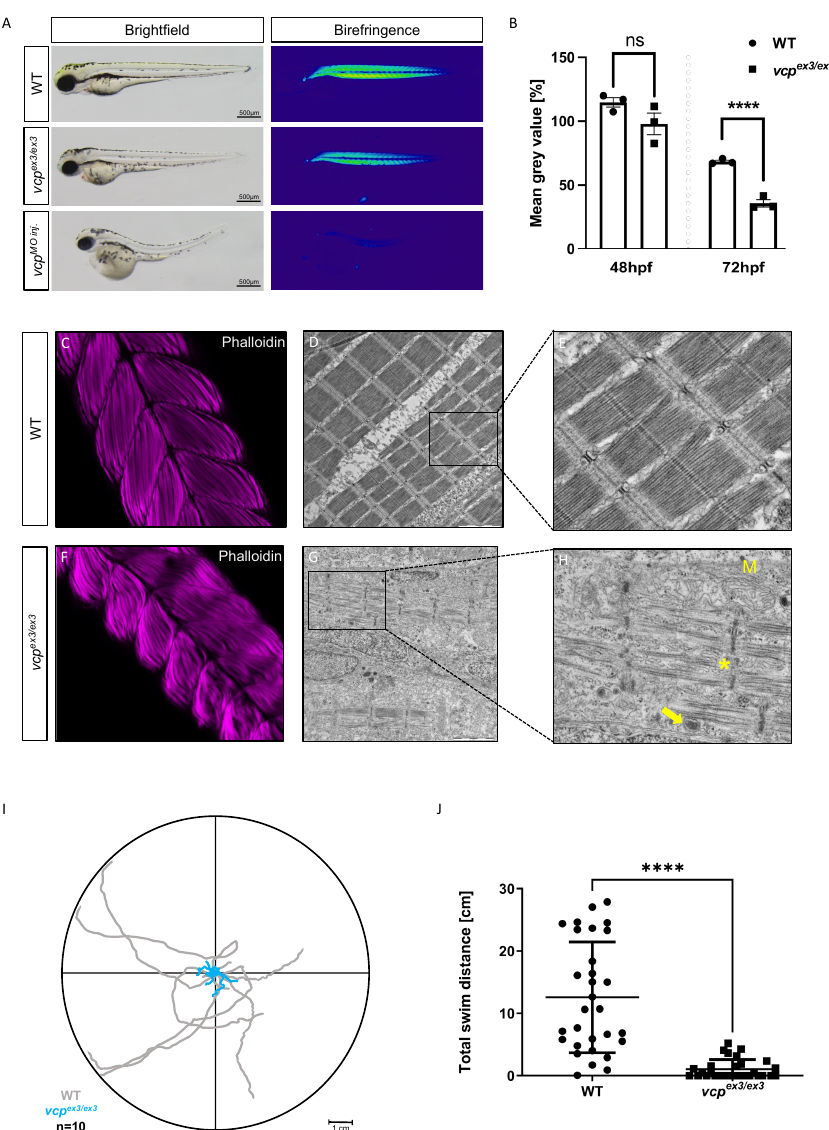
levels were unchanged in vcp ex3/ex3 mutant embryos (Figure 4B,D) (N = 4; p = 0.3143), suggesting activated mTOR signaling and thereby the repression of autophagy [31].